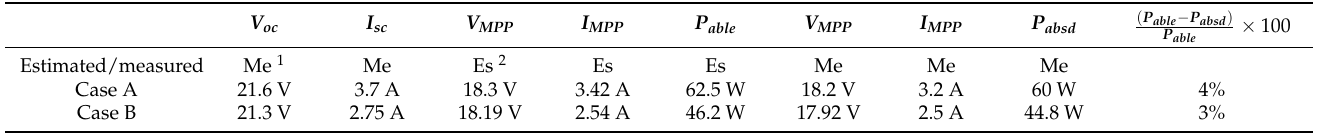
Table 4. Parameters of PV array at environmental